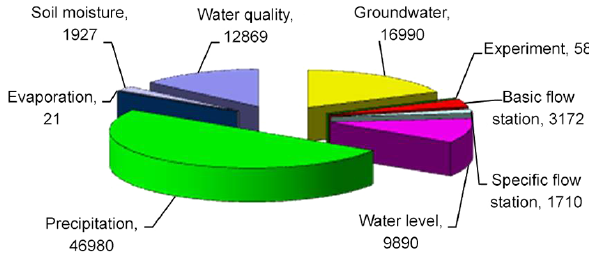
Figure 1. Distribution of water resources in China.